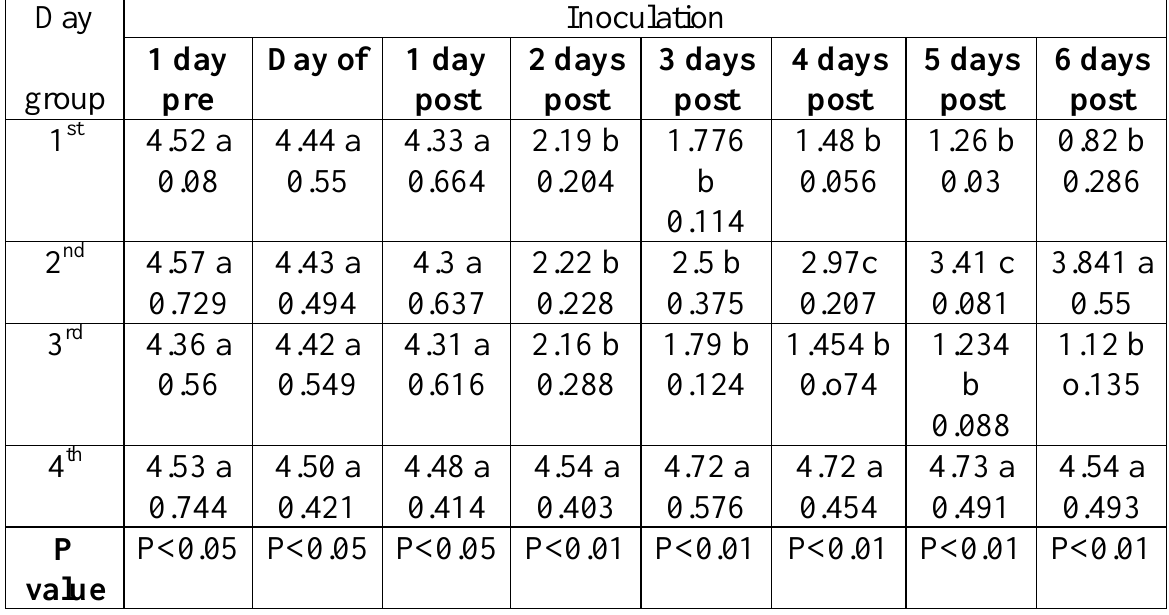
Table (4) Means ±SE. of serum potassium concentration by mmols/L in different